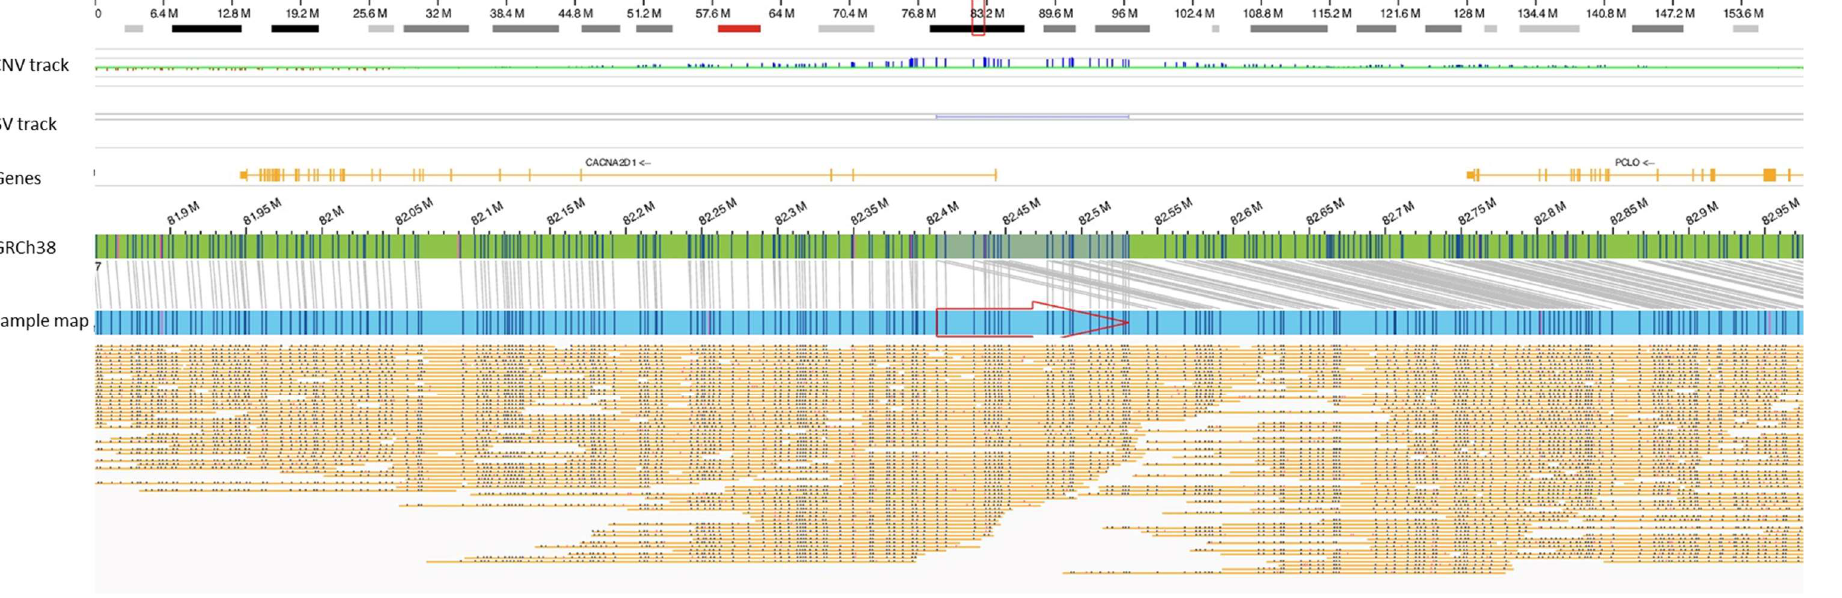
Figure 2. A ~126.5 kb duplication of chr 7 (chr7:82404497–82531042) disrupting the CACNA2D1 gene in one patient (case 53). The red arrow indicates a tandem duplication.